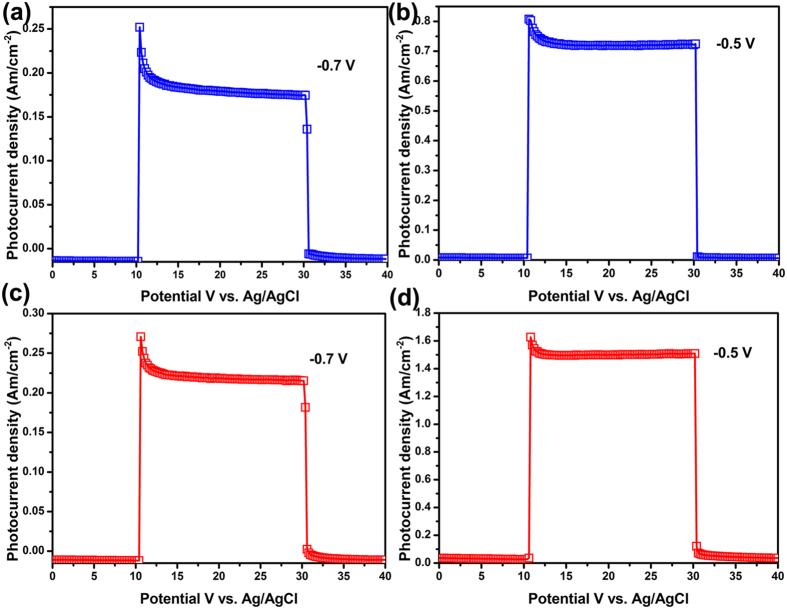
The transient photocurrent plots of (a,b) s-Bi2S3/WO3 and (c,d) i-Bi2S3/WO3 photoelectrodes at −0.7 and −0.5 V vs. Ag/AgCl, respectively.